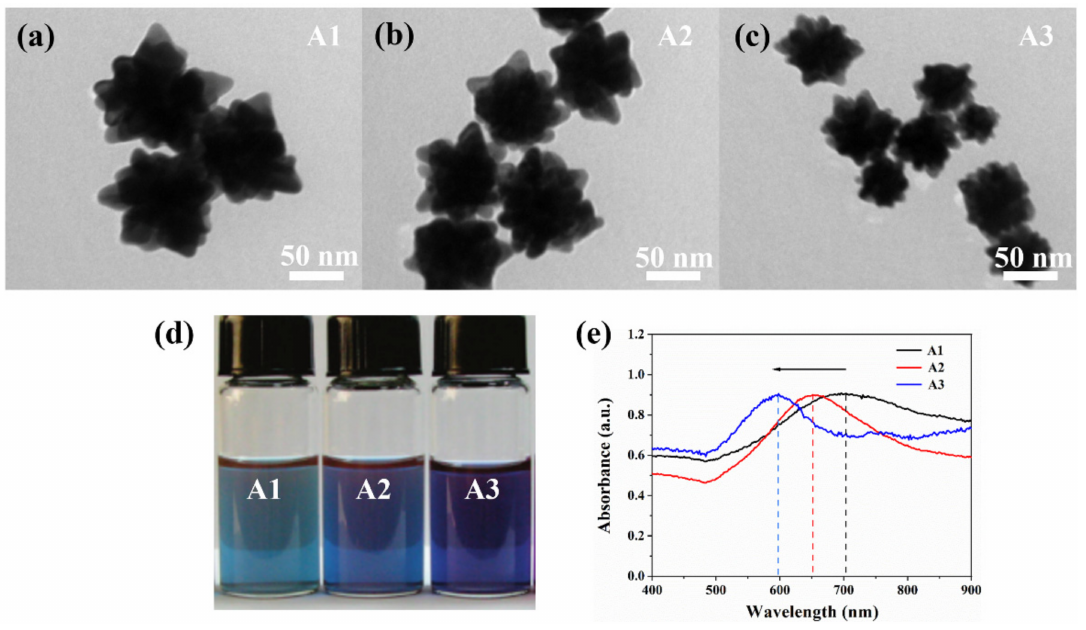
Figure 2. ( a – c ) TEM images, ( d ) corresponding solution color, and ( e ) UV-Vis spectra of A1, A2, and